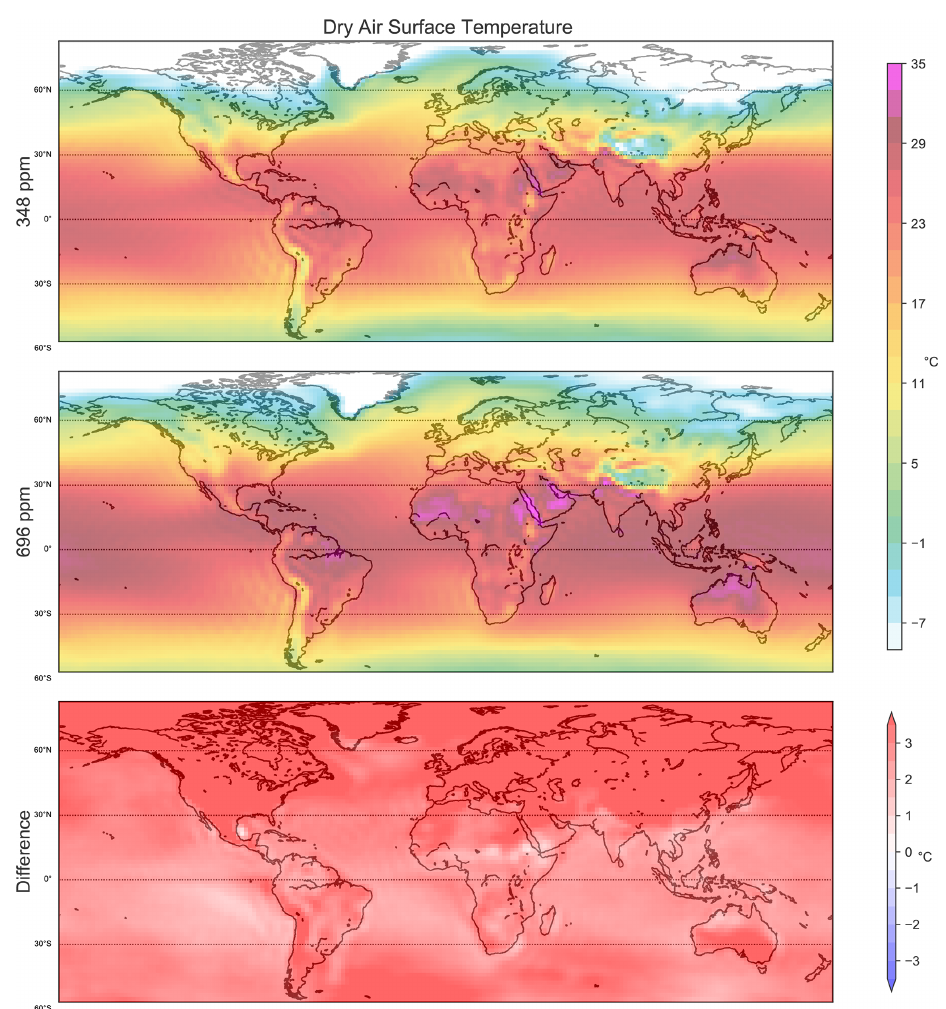
Figure A1. Surface temperature ( ◦ C) at spatial resolutions T63. In the radiation scheme, the first model configuration utilises a CO 2 volume mixing ratio of 348ppm (parts per million), whereas the second set-up uses 696ppm.